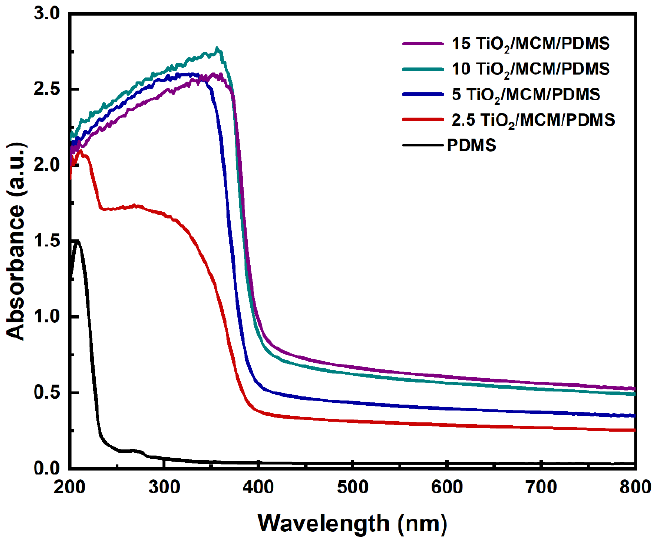
Figure 9. UV–Vis absorbance spectra of PDMS and TiO 2 /MCM/PDMS composites.